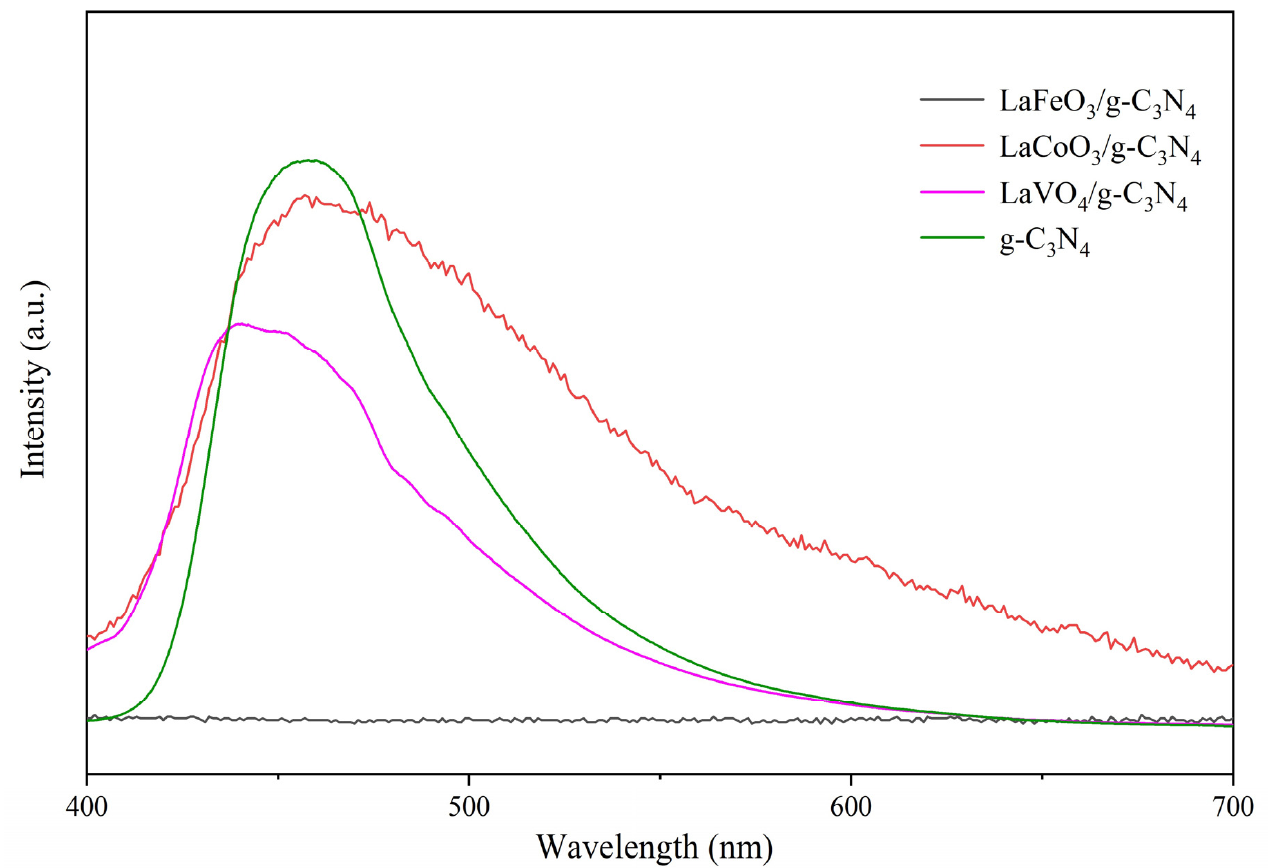
Figure 6. The photoluminescence of g-C 3 N 4 and LaAO x /g-C 3 N 4 (A = V, Fe,